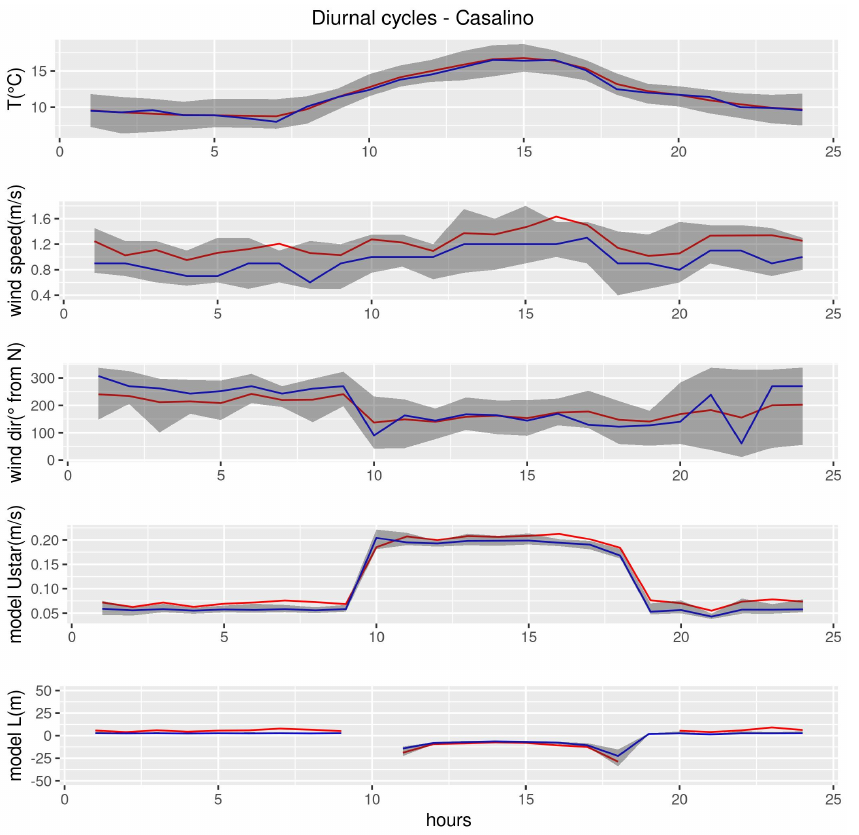
Figure 4. Diurnal cycle of measured air temperatures, wind speeds, and directions, together with the model-derived values of u* and L. Data refer to the period 1 October 2020 − 31 October 2020. Red/blue lines represent the mean (median) values, and the shaded areas the interquartile ranges (25% and 75%).